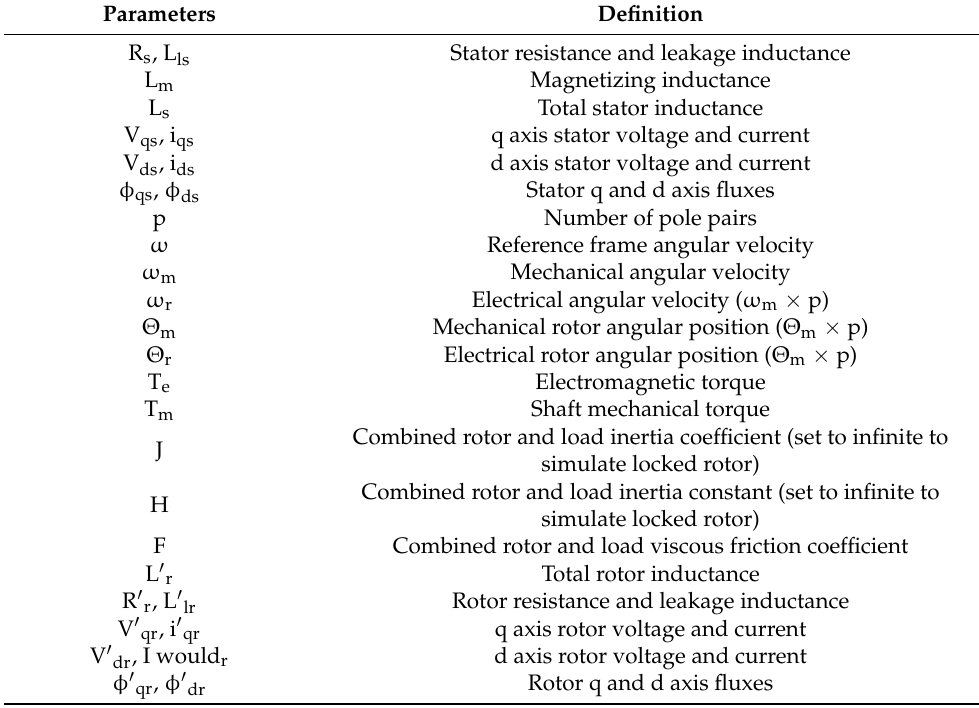
Table 2. Parameters involved in the DFIG